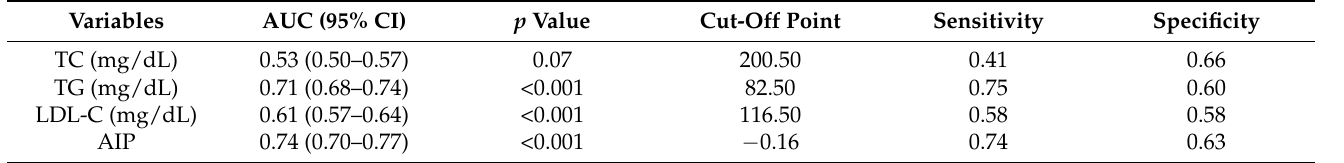
Figure 2. Comparison of the predictive performance of three lipid components and AIP for the presence of obesity. Table 4. Area under the ROC curve (95% CI) for obesity according to three lipid components and